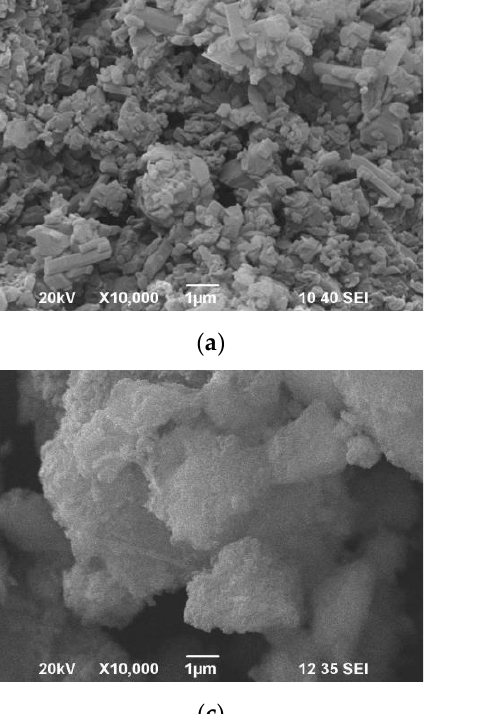
Figure 3. FTIR spectra of HNT, polyester plasticizer and PP-HNT in the 4000–500 cm −1 region. 3.1.2. Thermal Properties The thermal decomposition of glycerol, polyester plasticizer, and pure and modified halloysite is summarized in Table 2 and shown in Figure 4. The TG curve of pure HNT shows two phases of weight loss (Figure 4a,b). The mass loss from 25 °C to 150 °C is due to the removal of physically adsorbed water, while the mass loss in the temperature range of 150–403 °C is related to the removal of interlayer residual water. The mass loss above 403 °C is due to Al-OH and Si-OH groups dehydroxylation [45,46]. In contrast, PP-HNT and G-HNT show three weight loss phases with a gradual loss up to 262 °C and 164 °C, respectively, followed by two steeper weight losses (Figure 4a,b). The first mass loss up to about 100 °C is attributed to the adsorbed water loss, the second loss is due to the glycerol or polyester plasticizer loss (Figure 4c,d), and the third is due to the halloysite dehydrox- ylation. There was a significant decrease in the 5% weight loss temperature (T 5% ) com- pared to pure HNT results from the presence of an organic compound (glycerol, polyester plasticizer) in the halloysite structure, which degrades at a much lower temperature (Fig- ure 4c,d, Table 2). The HNT modification caused a decrease in a maximum rate of decom- position temperature (T max3 ) compared to the T max of pure HNT (Figure 4b).